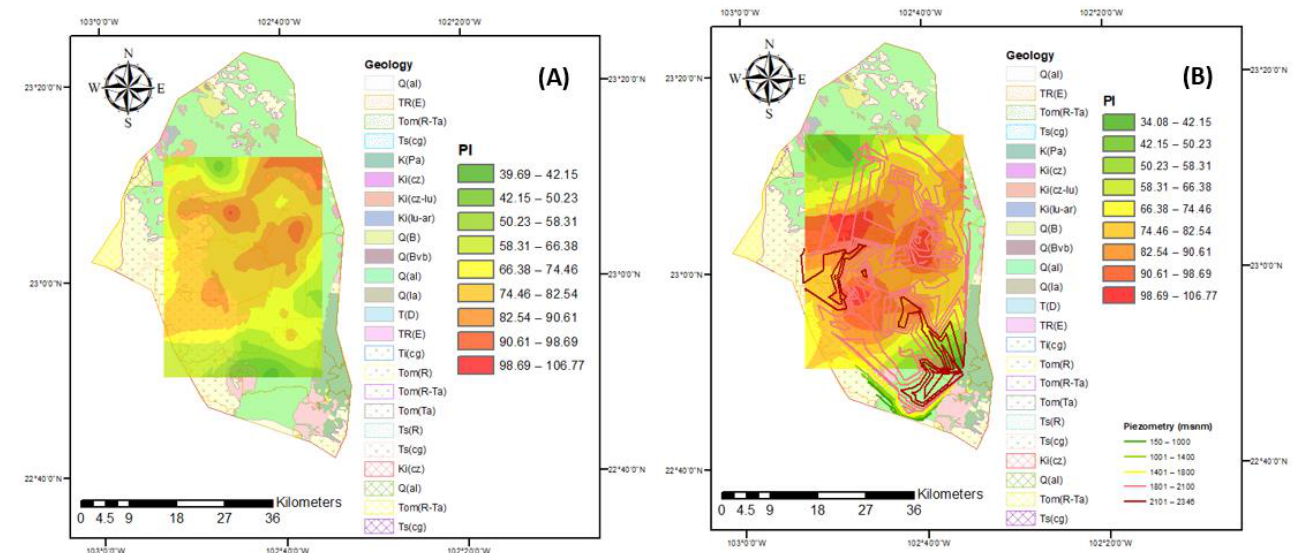
Figure 11. PI index for the years ( A ) 2005 and ( B ) 2015.